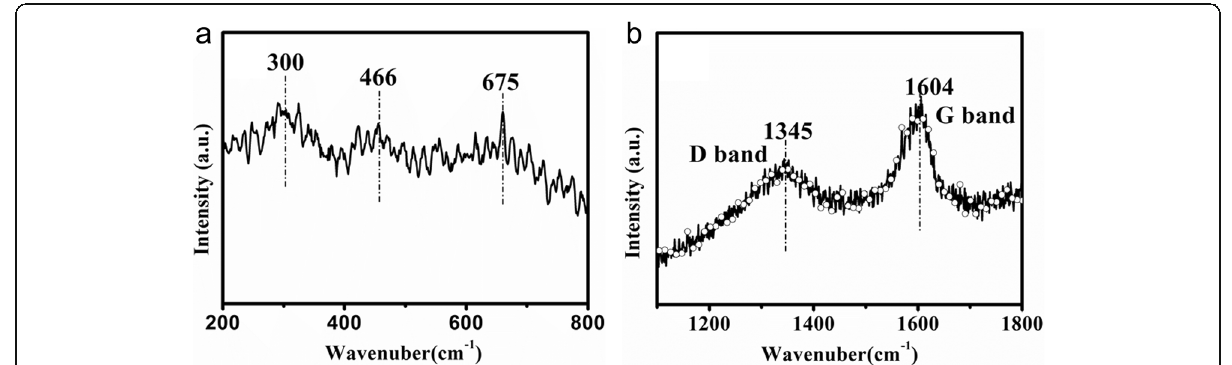
Fig. 2 Raman spectra of a CoFe 2 O 4 and b